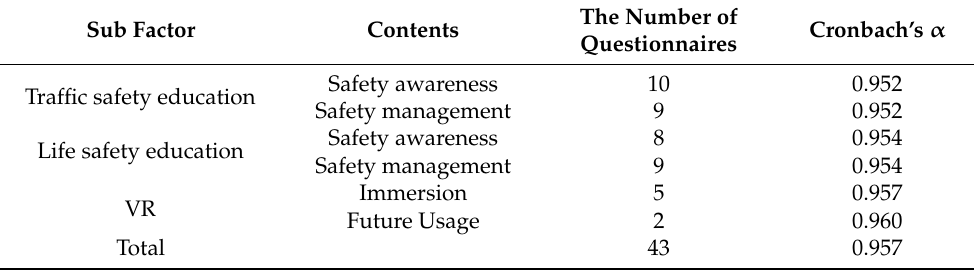
Table 1. Safety education effect questionnaire using virtual